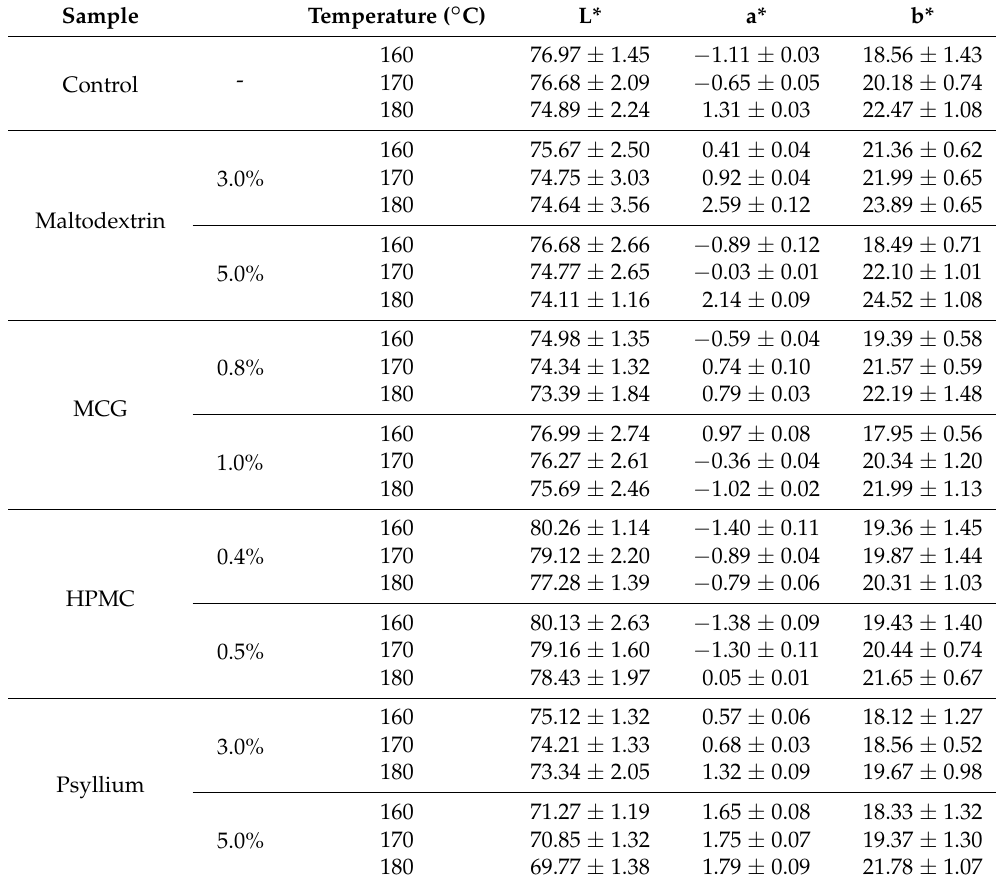
Table 2. The color characteristics of selected instant fried noodles